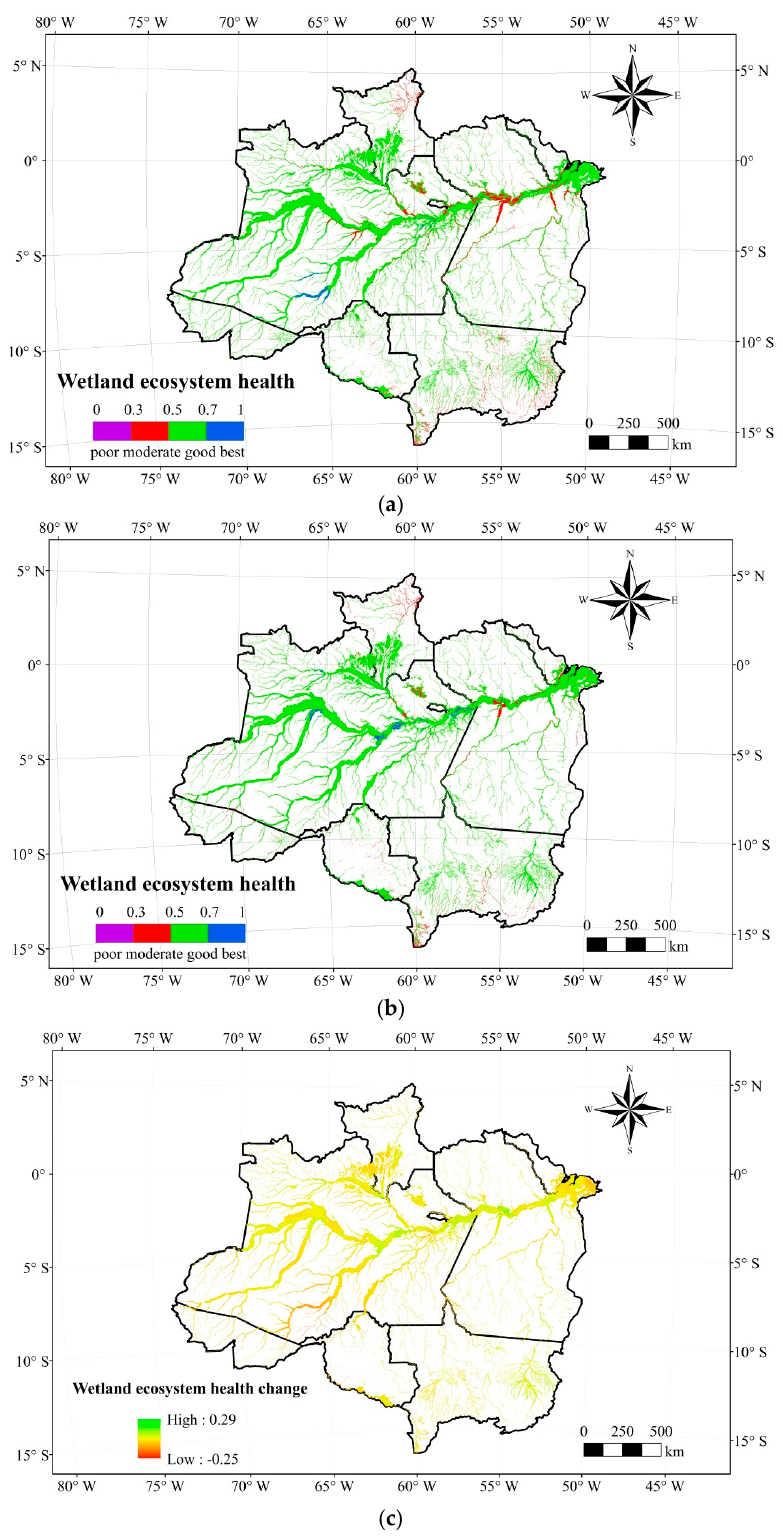
Figure 3. Spatial pattern of wetland ecosystem health in the Amazon River Basin in 2000 and 2010. ( a ) 2000; ( b ) 2010; ( c ) Change in wetland ecological health index from 2000 to 2010.